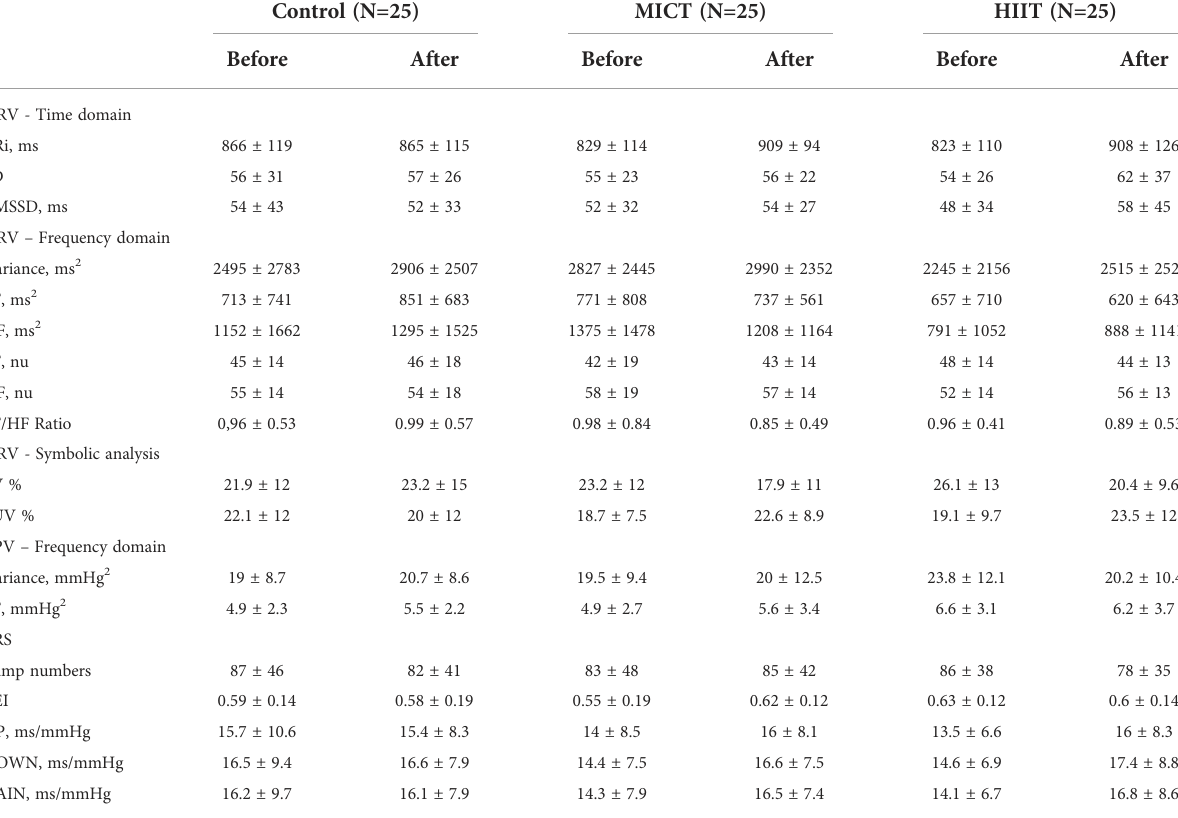
TABLE 4 The descriptive table of cardiovascular autonomic parameters obtained before and after the 16-wk of physical training (MICT and HIIT groups) or observation period without training (Control group). Control (N=25) MICT (N=25) HIIT (N=25) Before After Before After Before After